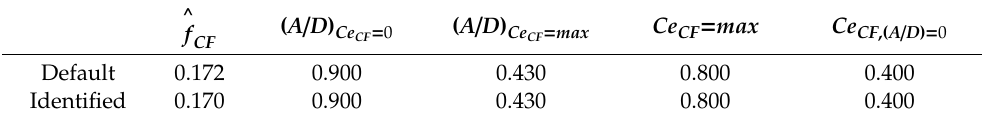
Figure 5. Comparison between the contour curves of ( a ) default parameters; ( b ) identified optimal parameter set no. 2660. Table 6. Comparison between the identified parameters by the algorithm and the default parameters.